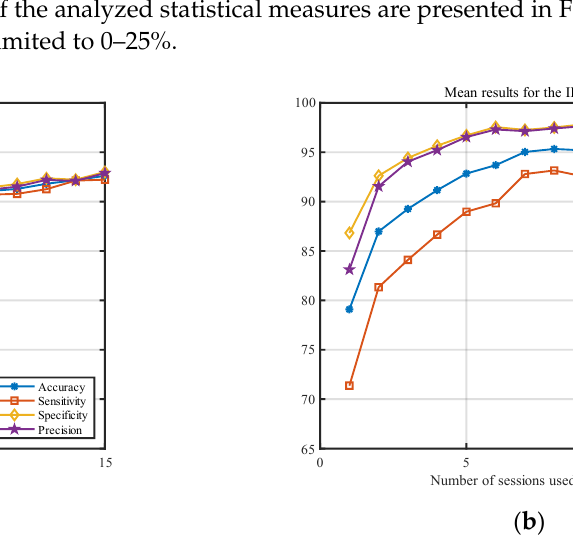
( b ) Figure 4. Results for standard deviation, according to the number of sessions used for training, av- eraged over all participants for the ( a ) I approach and ( b ) II approach. The results presented in Figures 3 and 4 indicate that, as the number of training ses- sions increases, the classification measures tend to improve for both approaches. The per- formance measures increase, and the standard deviations decrease significantly. This is particularly noticeable for the small number of sessions (1 – 8). One of the most important conclusions is that PSD estimate coefficients provide better results for all considered clas- sification measures when converted to the decibel scale. Moreover, the results for the II approach tend to stabilize faster and show less fluctuation between the obtained results in the last sessions. The results from Figures 3 and 4 are also presented in Tables 1 and 2 to enable a more detailed comparison.